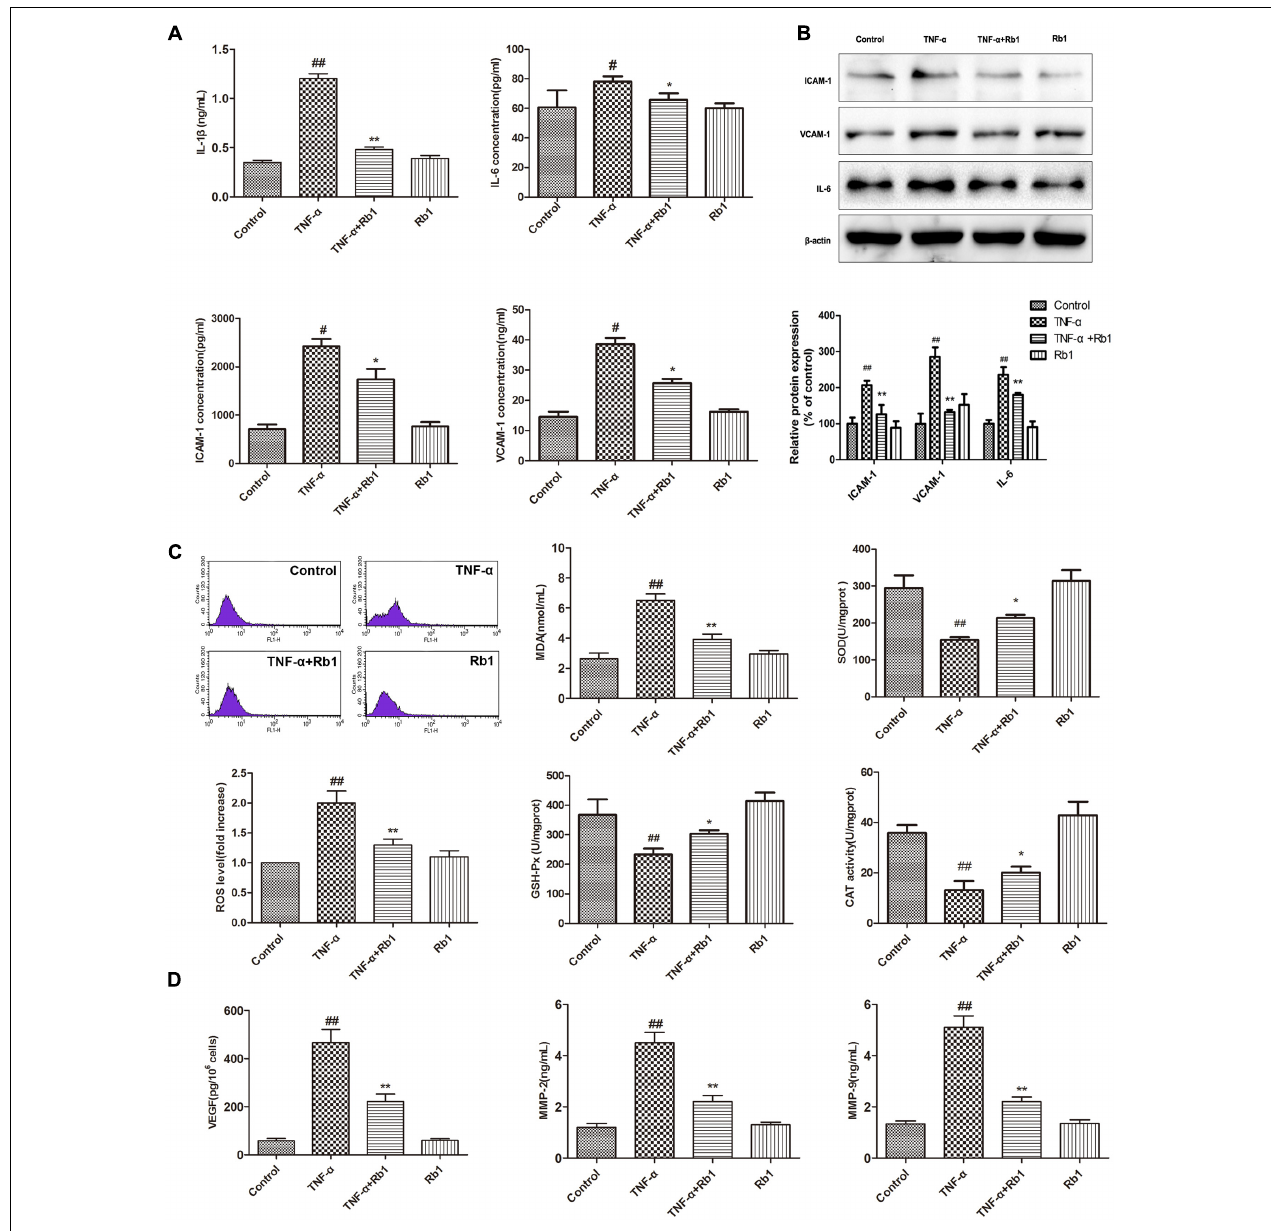
FIGURE 2 | Ginsenoside Rb1 could suppress TNF- α -induced inflammation in HUVECs. HUVECs were treated with TNF- α for 24 h after incubation with Rb1 (20 µ g/mL) for 8 h. (A) The levels of IL-1 β , ICAM-1, VCAM-1, and IL-6 were measured by ELISA. (B) The protein expression levels of ICAM-1, VCAM-1, and IL-6 were determined by western blot and quantified using densitometric analysis. (C) ROS levels were detected by flow cytometry, and the levels of MDA and the activities of SOD, CAT, and GSH-Px were detected by respective assay kits. (D) The levels of VEGF, MMP-2, and MMP-9 in HUVECs were detected by ELISA. Data were expressed as the mean ± SD of three independent experiments. ## P < 0.01 vs. control group; ∗ P < 0.05, ∗∗ P < 0.01 vs. TNF- α treatment